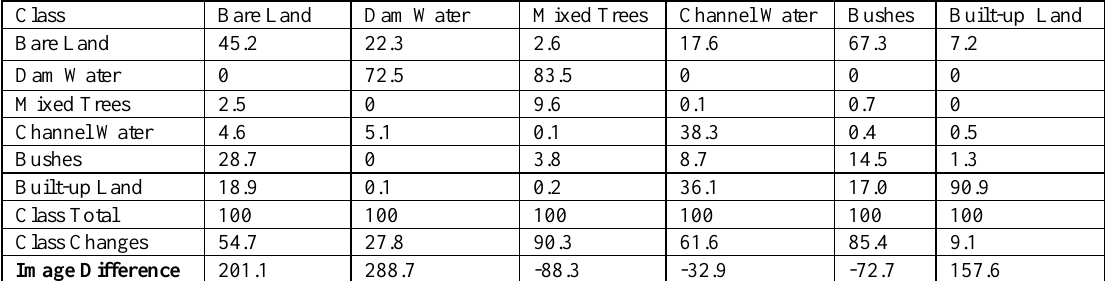
Table 4: Change Detection Percentage Operational Land Imager Data from Winter to Autumn Season Class Bare Land Dam Water Mixed Trees Channel Water Bushes Bare Land Dam Water Mixed Trees Channel Water 1.75 Bushes Built-up Land Class Total Class Changes